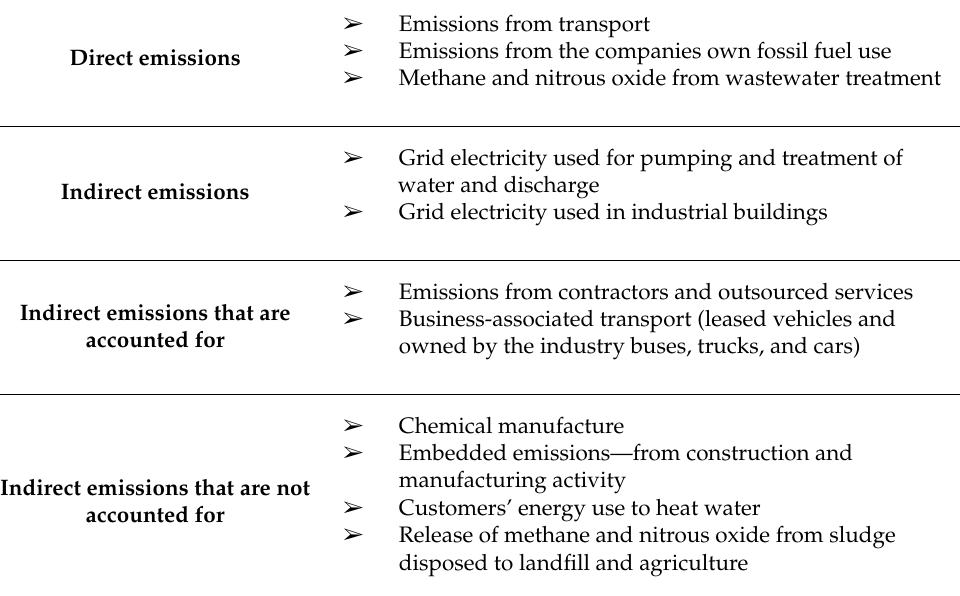
Table 1. Direct and indirect emissions